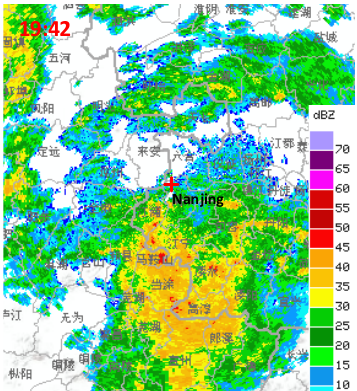
Figure 9. Radar chart displayed at 19:42.